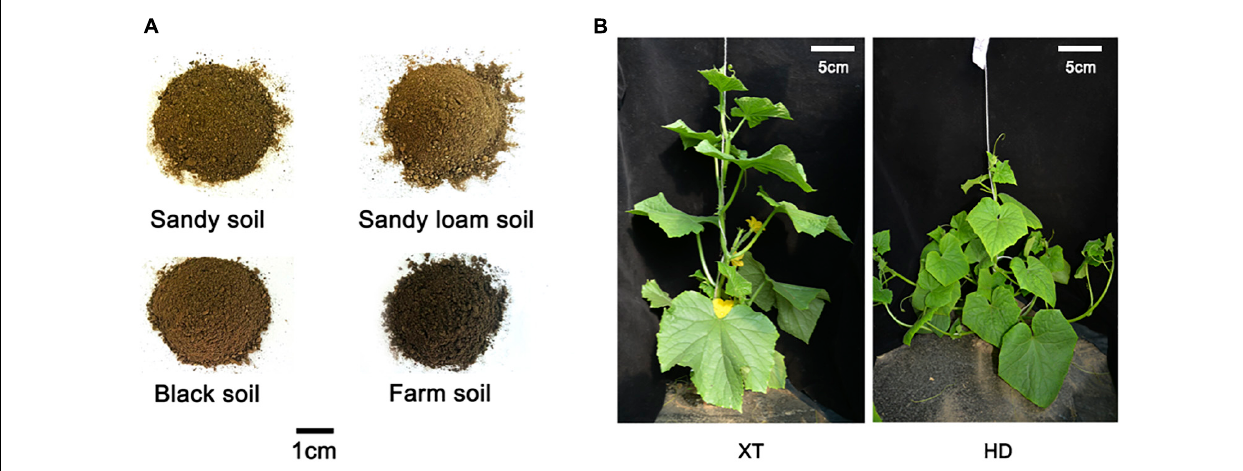
FIGURE 1 | Four different soils and two different cucumber genotypes. (A) There are four kinds of representative soils selected from different regions: sandy soil, sandy loam soil, black soil, and farm soil. (B) XT on the left and HD on the right.